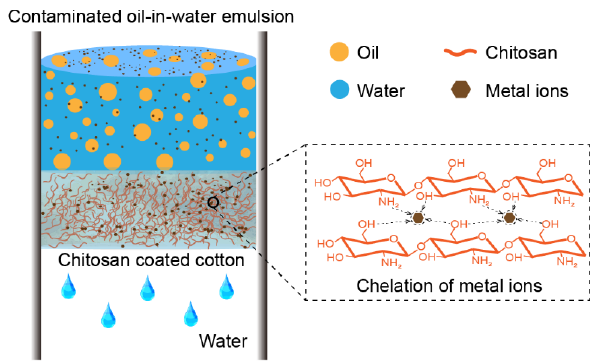
Figure 7. The mechanism of separation of heavy metal ion-contaminated oil-in-water emulsions with compressed CTS-coated cotton. The heavy metal ion-contaminated aqueous solution continuously flows through the cotton, during which the metal ions are absorbed by CTS, and the microdroplets of oil are rejected on the cotton surface due to the underwater superoleophobicity.